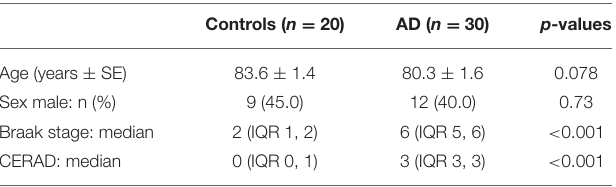
TABLE 1 | Demographic data and neuropathological assessment of Alzheimer’s disease and control patients. Controls ( n = 20) AD ( n = 30) p -values